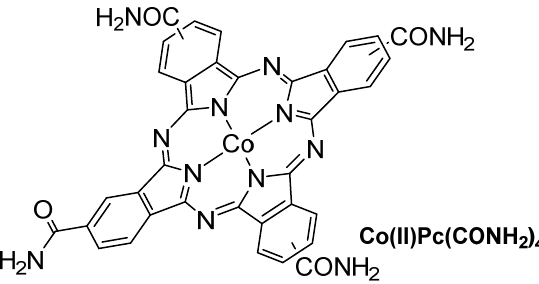
Figure 32. Co(II) tetraamide phthalocyanine Co(II)Pc(CONH 2 ) 4 (adapted from